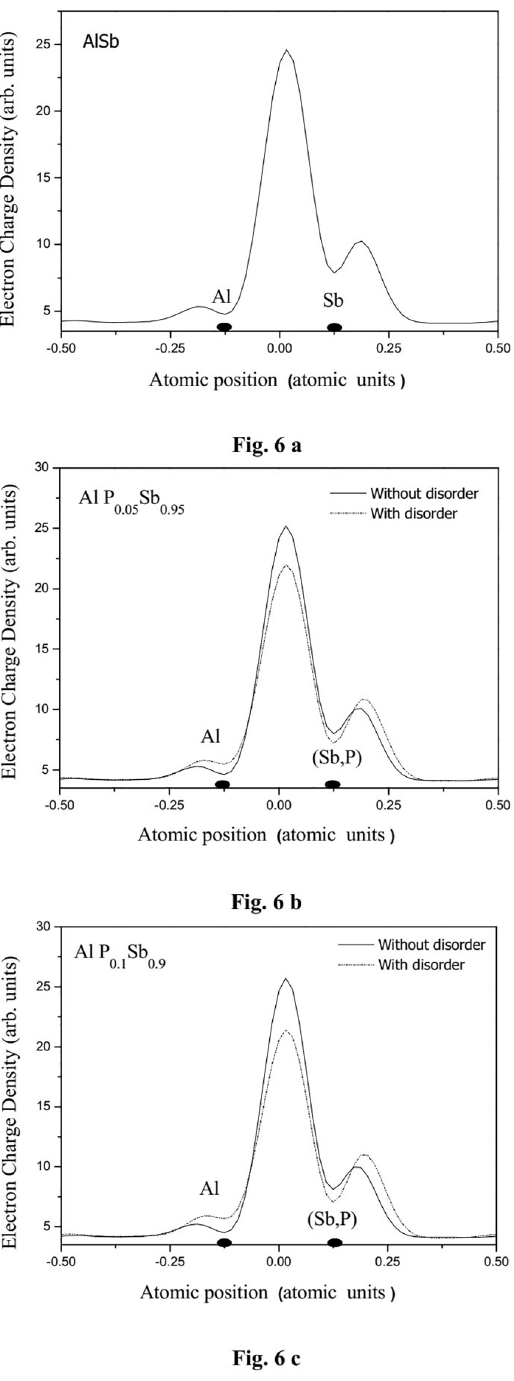
Figure 6. (a) . Electron total valence charge density at the Γ point along the [111] direction for AlSb. (b) . Electron total valence charge density at the Γ point along the [111] direction for AlP P 0.1